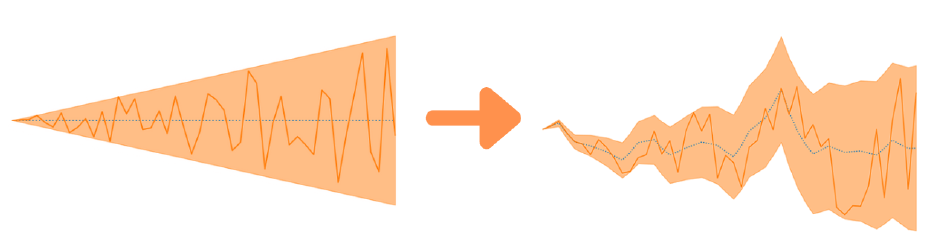
Figure 8. Example of the shape of a linear margin function on flat original data ( left ) and on actual power data of the London dataset ( right ). The blue line depicts the original power data and the orange line is an example of power forecast data within the orange uncertainty area based on the margin